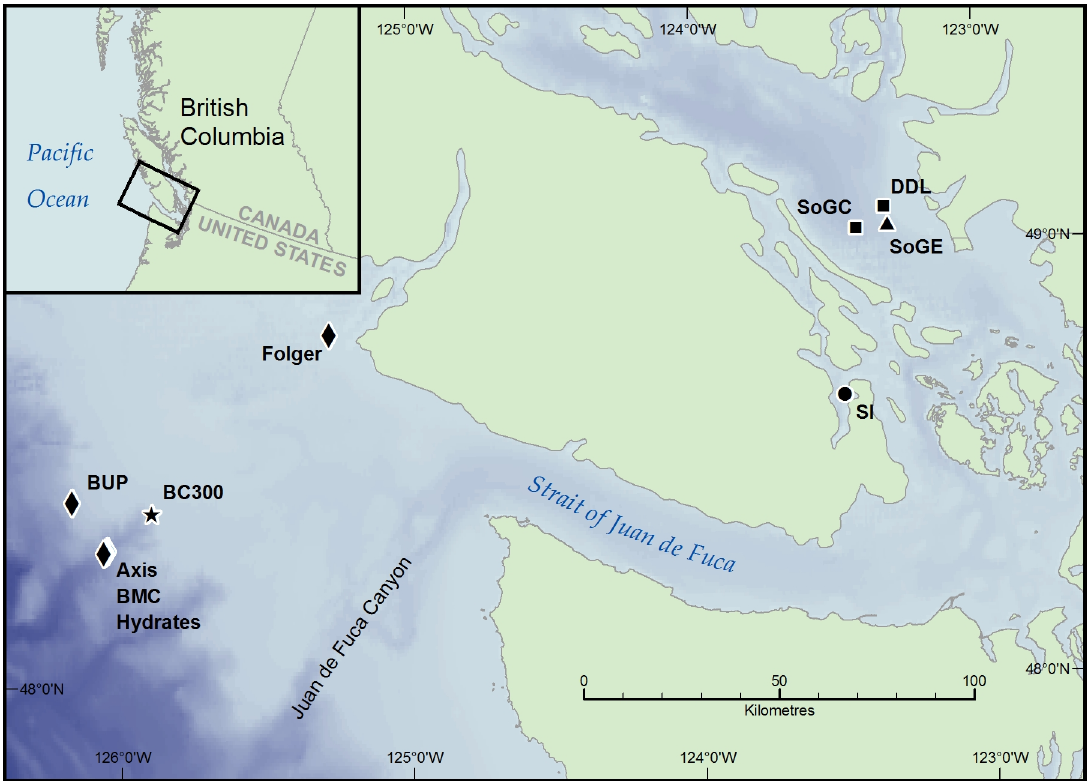
Fig 1. Map of stations sampled in the Salish Sea and the North East Pacific in May/July 2011 and September 2013. Label symbols indicate sampling dates. 1) Squares: DDL and SoGC were sampled in May and July 2011; 2) Triangle: SoGE was sampled in May 2011 and September 2013; 3) Circle: SI was sampled in July 2011 and September 2013; 4) Diamonds: Axis, BMC, Hydrates, BUP and Folger were sampled in July 2011; 5) Star: BC300 was sampled in September 2013. Bathymetry data based on the GEBCO_2014 Grid, version 20150318,